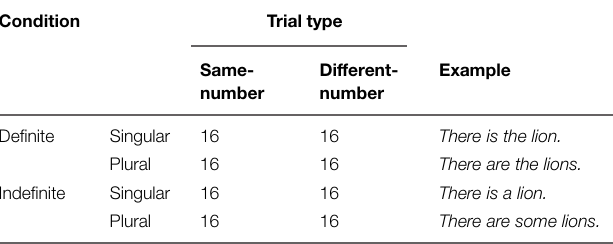
TABLE 1 | Composition of test trials in Experiment 1.